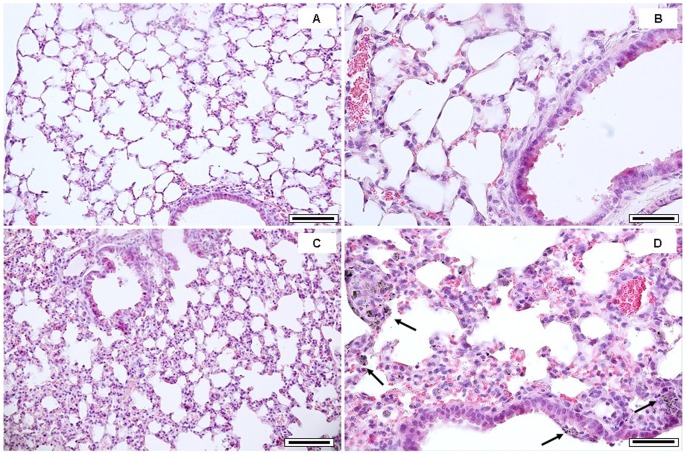
Lung histological analysis.Histology of lung tissue 24 h after the third intratracheal instillation. (A, B): lung parenchyma of sham mice, showing bronchiolar and alveolar epithelia; (C, D): PM10sum-treated lung parenchyma, showing inflammatory cells recruitment and AMs infiltration (arrows) in the connective surrounding terminal bronchioles and proximal alveolar sacs. Each figure represents the status evidenced examining 6 sham and 6 PM10sum-treated mice. A and C bars = 150 µm; B and D bars = 50 µm.